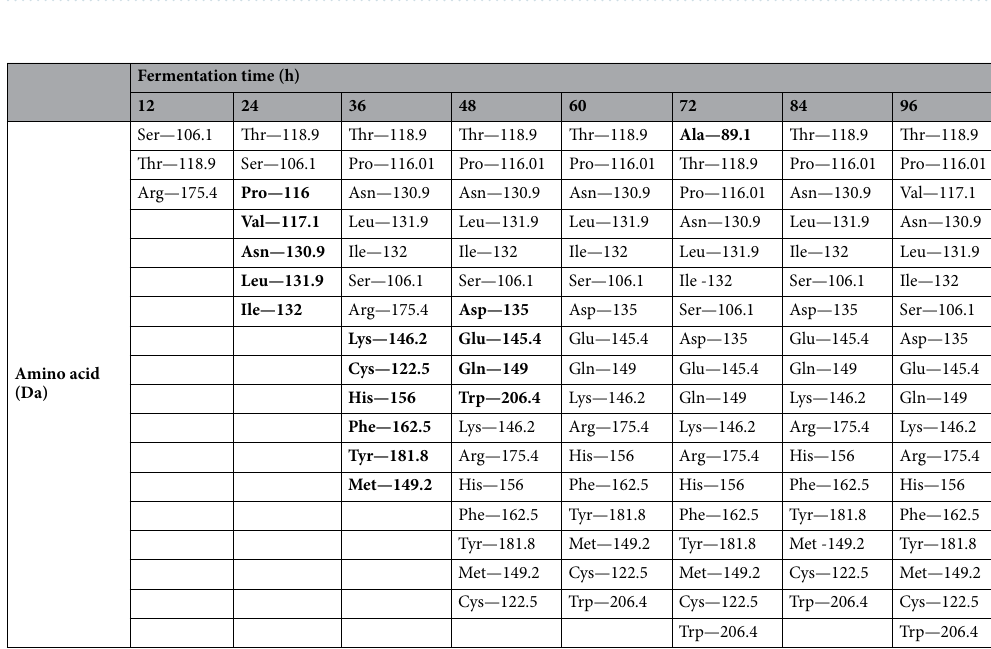
Figure 5. X-ray diffraction patterns of the intact (blue) and hydrolyzed feather samples at different time intervals 48 h (black) and 96 h (red) of incubation.